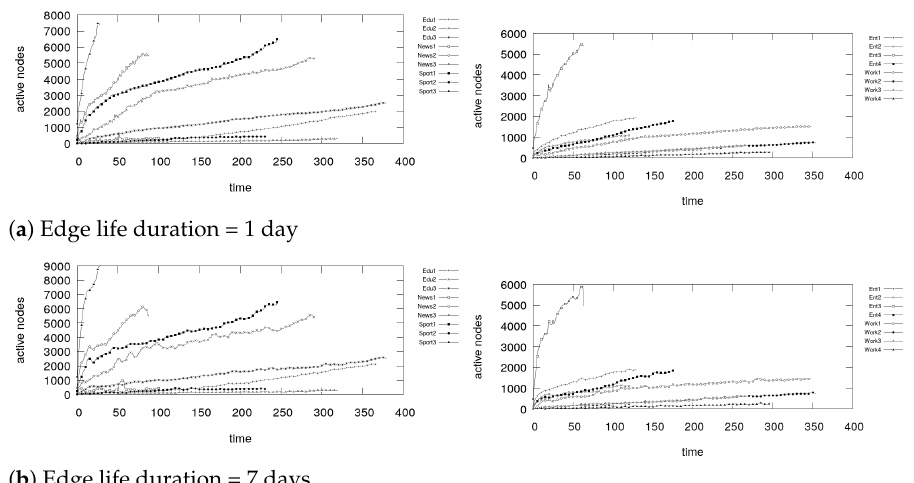
Figure 15. Number of active nodes detected by Multilevel.